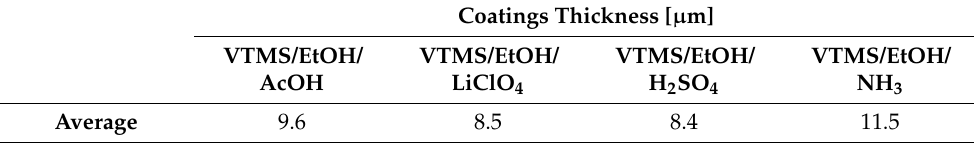
Table 6. Coating thickness measurement results using a gauge Testan DT-20.